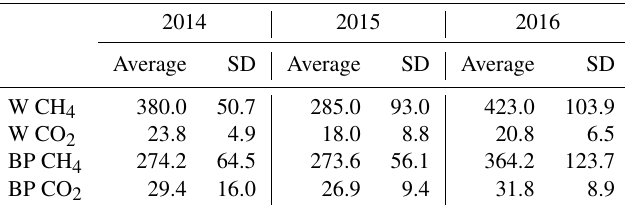
Table 2. Average methane (CH 4 ) and carbon dioxide (CO 2 ) concentrations (mLL − 1 ), with the standard deviation (SD) of gas-releasing bubbles from pools (W) and bare peat surfaces (BP) in the three studied years (2014–2016).